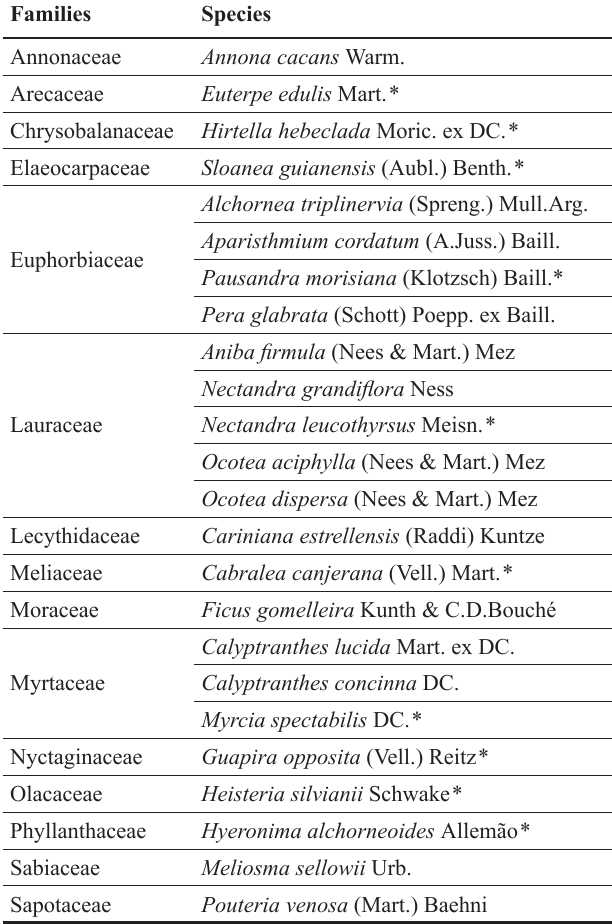
Table 2 – List of families and species of the Ombrophilous Dense Forest that reached the distribution range of 5 ° along the latitudinal gradient (excluding the area of secondary forest sampled in São Pedro de Alcântara, SC). * species that occurred throughout the gradient (range of 6°), considering all sample